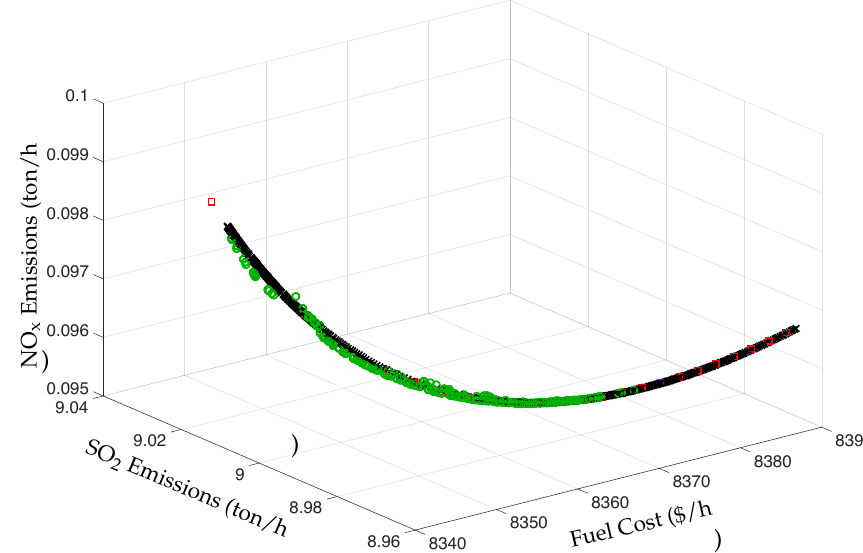
Figure 9. Pareto front for fuel cost, SO 2 emissions, and NO x emissions constructed using 500 elements. Red squares represent SQP, green circles represent NSGA-II, and black × represent